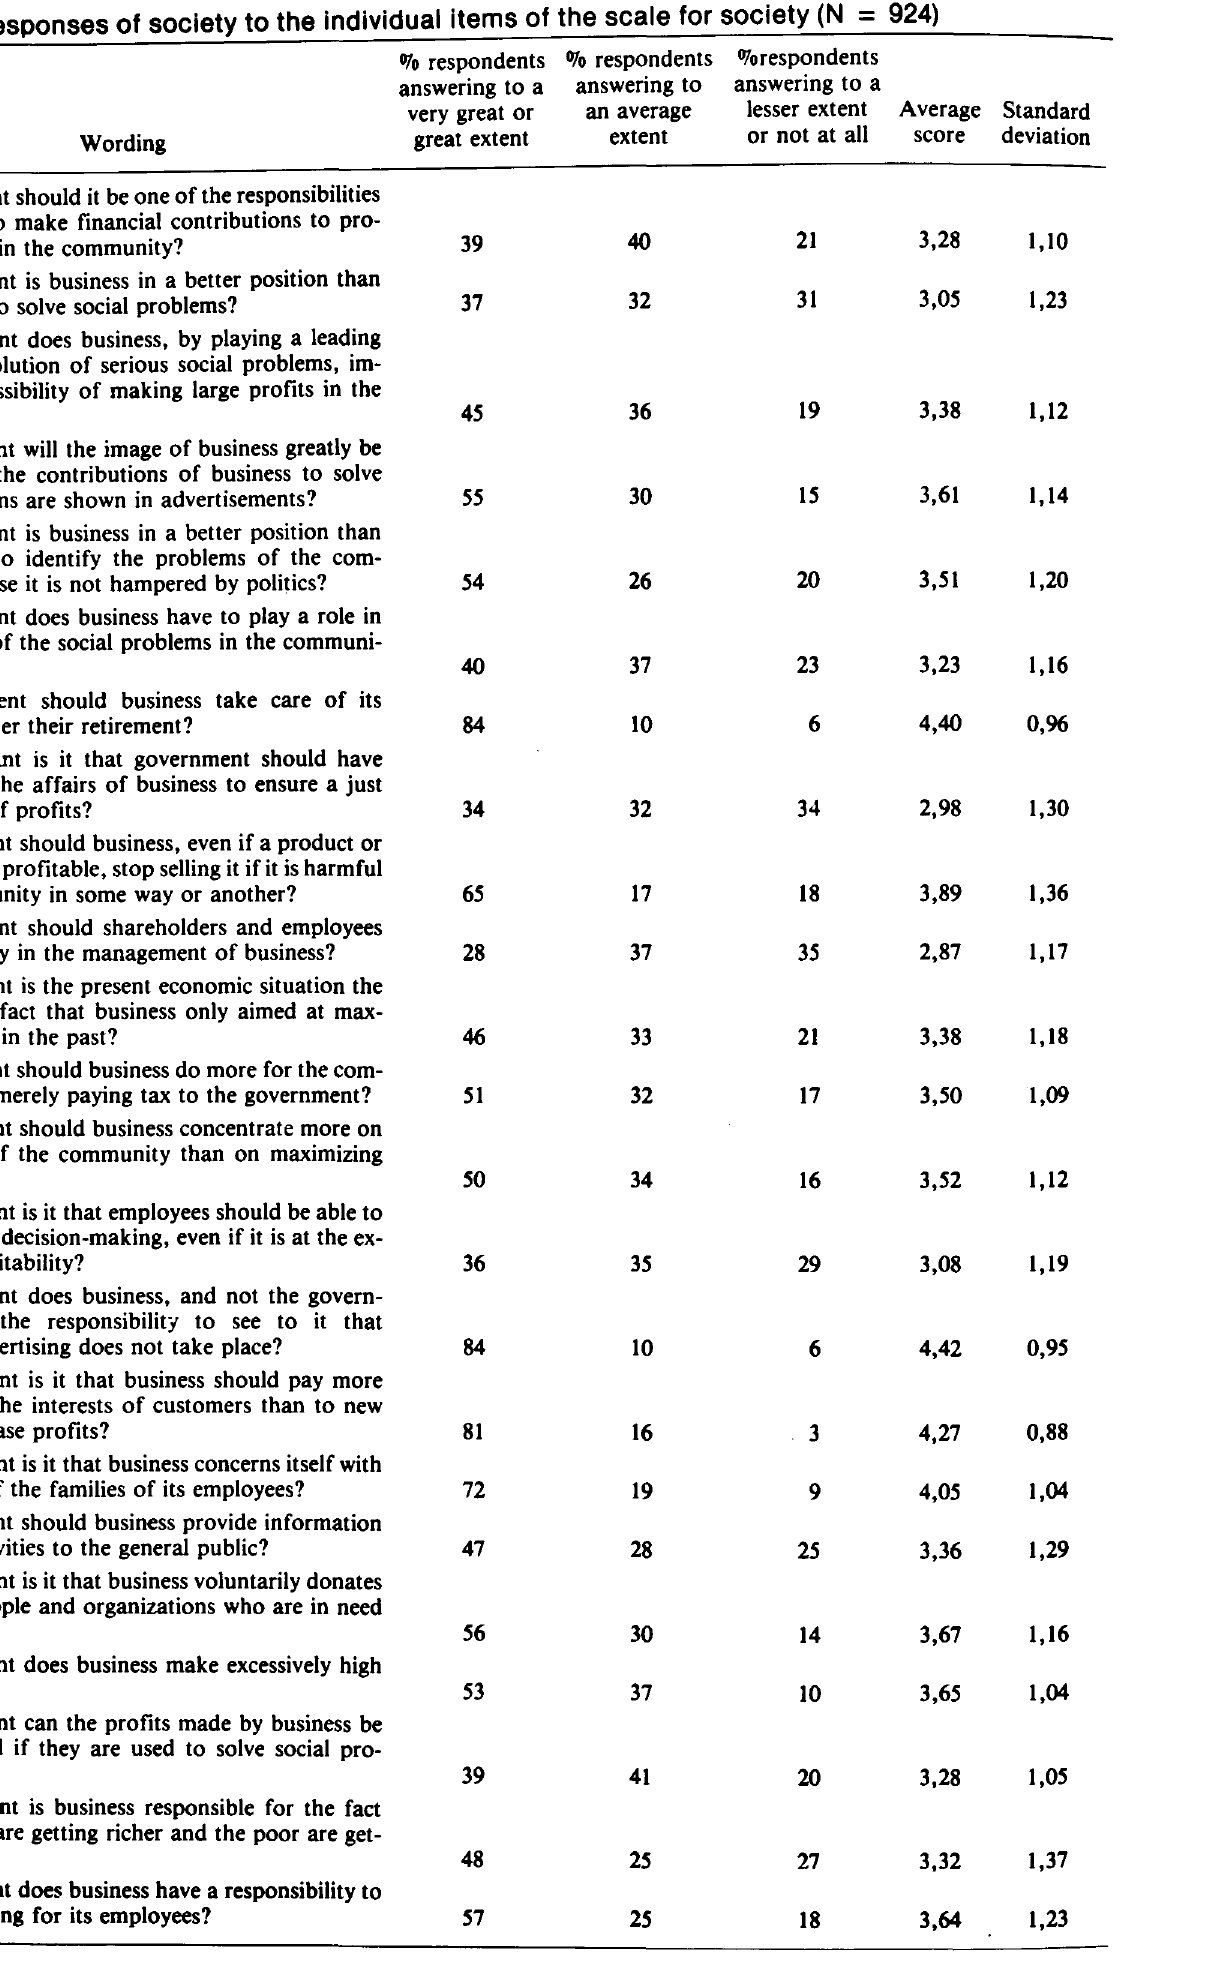
The responses of society to the individual items of the scale for society (N =